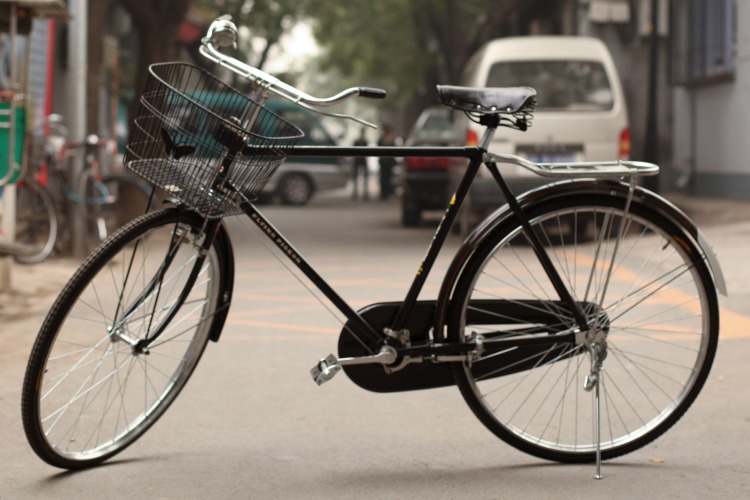
Human powered bike.